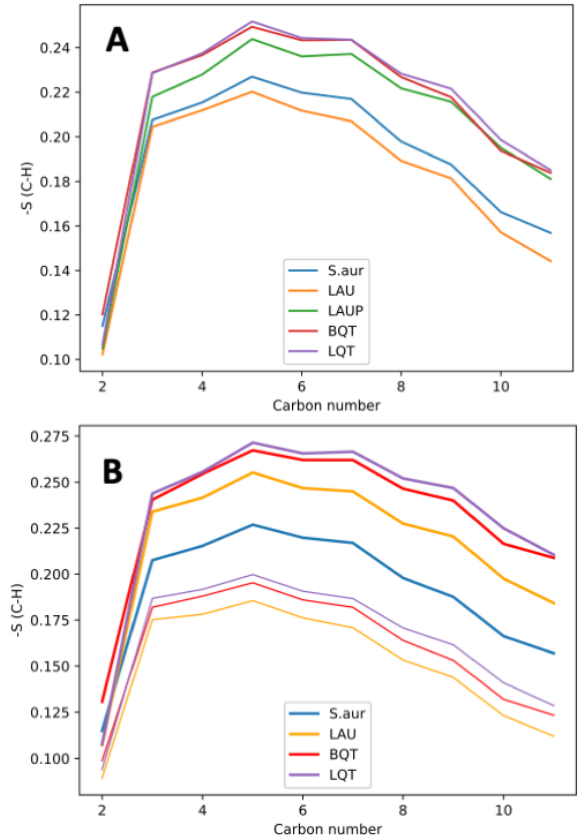
Figure 4. Order parameter for each carbon in the sn -2 tail of AMPG lipids in each membrane. ( A ) Symmetric membranes. ( B ) Asymmetric membranes with the enriched lower leaflet in thin lines and the empty leaflet in thick lines.